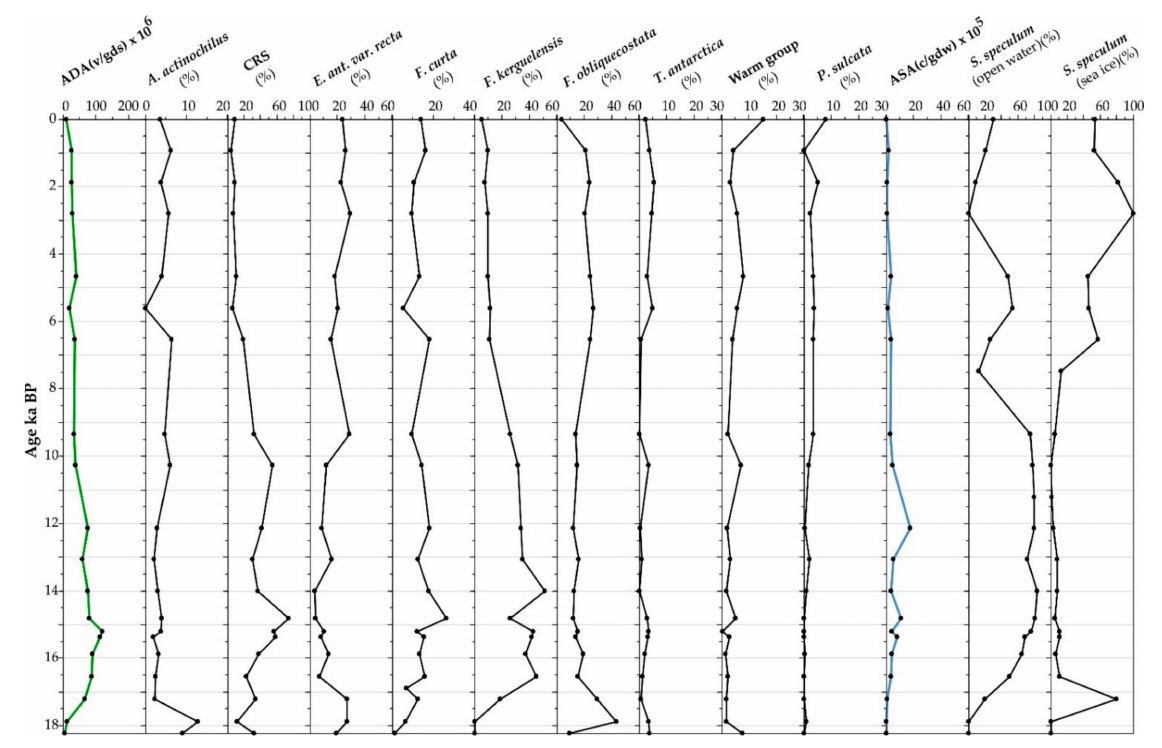
Figure 8. Down-core distribution of diatom and silicoflagellate present in BC02. The variety S. speculum var. monospicata and var. bispicata , with var. speculum , represent the open ocean, while S. speculum var. coronata represents the marginal ice zone and the Ross Sea coastal areas.